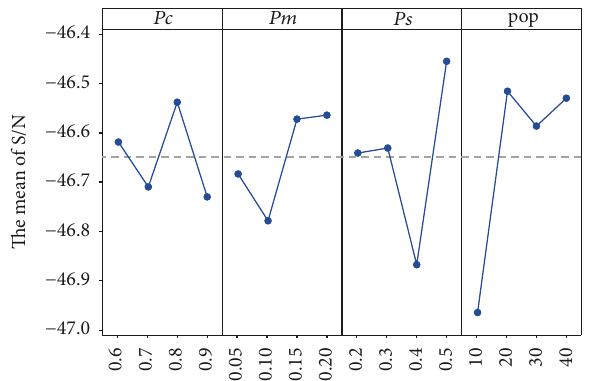
Figure 11: Main effects plot for S/N of GA factors.